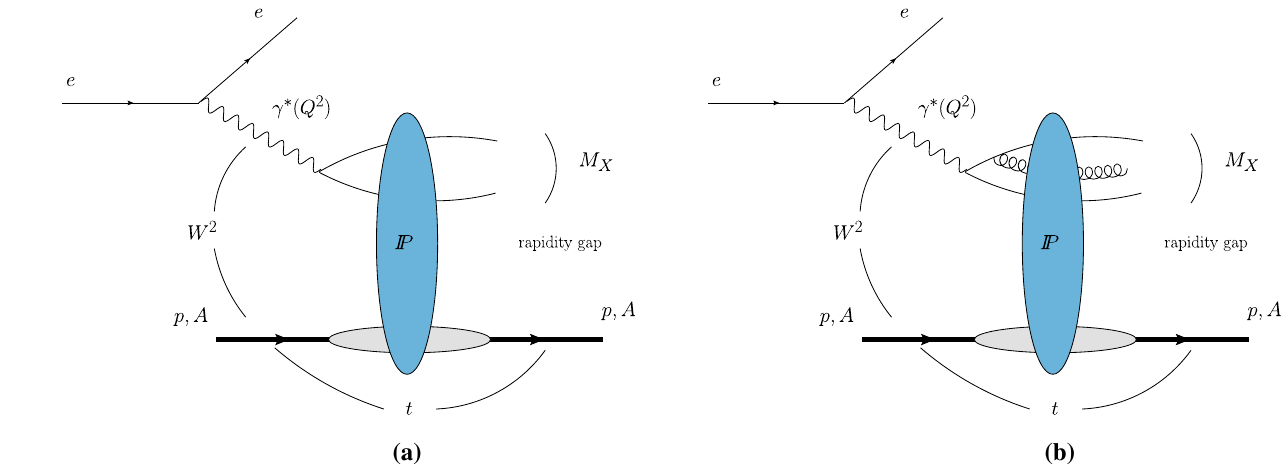
Fig. 2 Diffractive deeply inelastic electron-hadron scattering in the color-dipole formalism, which assumes that the virtual photon fluctu- ates into a colorless parton Fock state, which interacts elastically with